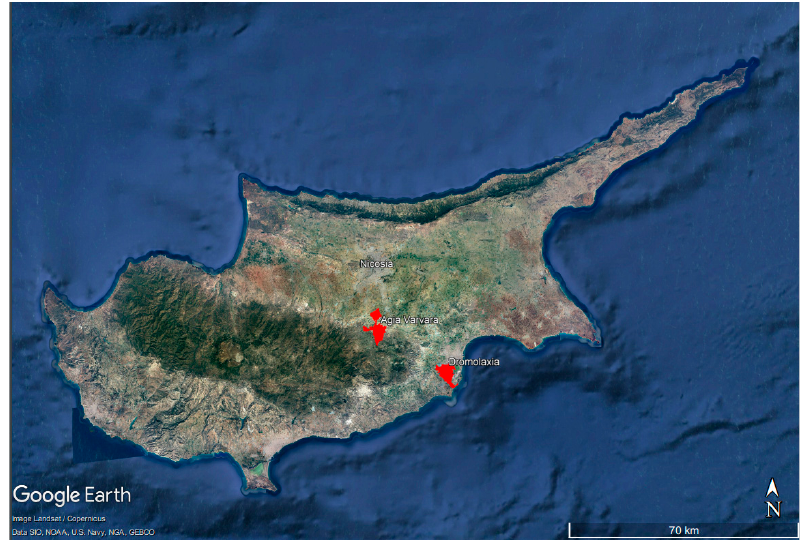
Figure 2. Google Earth image of the areas from which data were collected in Cyprus .